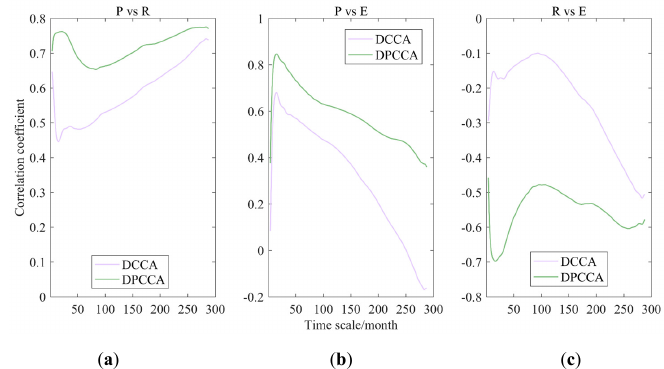
Figure 3. Cross-correlation coefficients among precipitation (P), runoff (R), and evaporation (E) obtained by detrended cross-correlation analysis (DCCA) cross-correlation coefficient and detrended partial cross-correlation analysis (DPCCA), i.e., P-R ( a ), P-E ( b ), and R-E ( c ). cross-correlation analysis (DPCCA), i.e., P-R ( a ), P-E ( b ), and R-E ( c